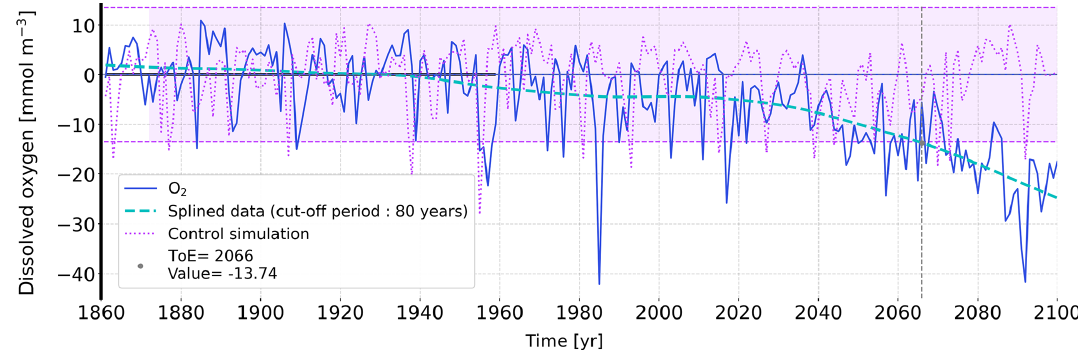
Figure A1. Illustration of the ToE method by using simulated oxygen concentration of the MPI-ESM-LR model averaged over 200–600m in one grid cell in the western North Pacific. The dark blue line shows that temporal evolution of oxygen anomalies from 1860 to 2099 relative to preindustrial concentrations (1860–1959). The two pink lines indicate the magnitude of the noise, N , which is computed as 2 standard deviations from annual output of the control simulation. The anthropogenic signal, S , is the simulated oxygen concentration over 1860 to 2099 from the forced simulation splined with a 80-year cut-off period (dashed cyan). Here, the resulting ToE is the intersection between the lower limit of the noise and the splined signal (vertical dashed line).